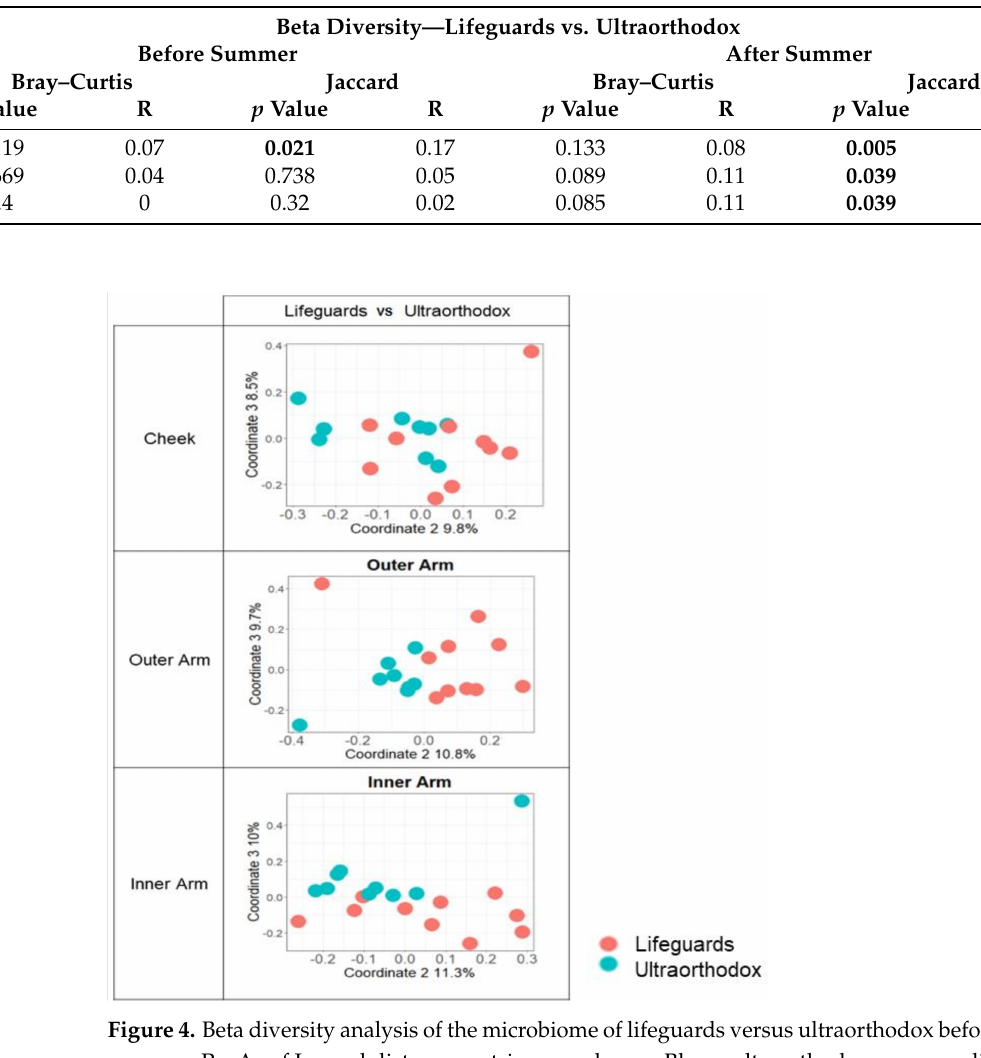
Table 2. Beta diversity analysis of the microbiome of the lifeguards versus ultraorthodox before and after summer. Between-group dissimilarities were calculated using Jaccard and Bray–Curtis distances. Bold indicates significant difference.